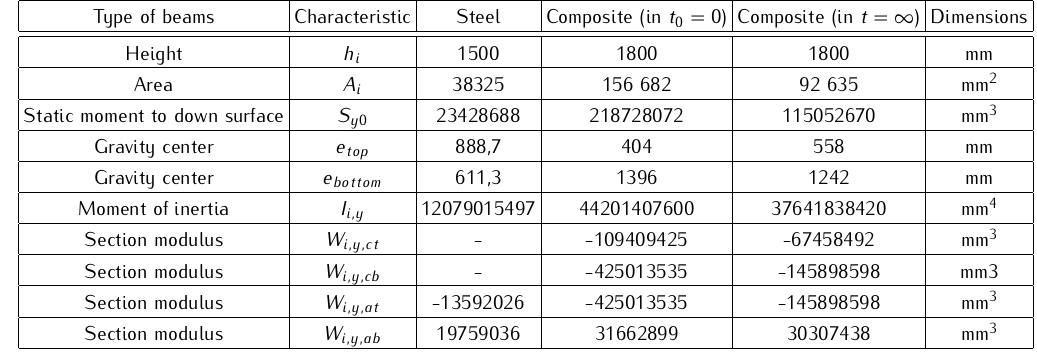
Table 1. Dimensions of steel and composite beams.